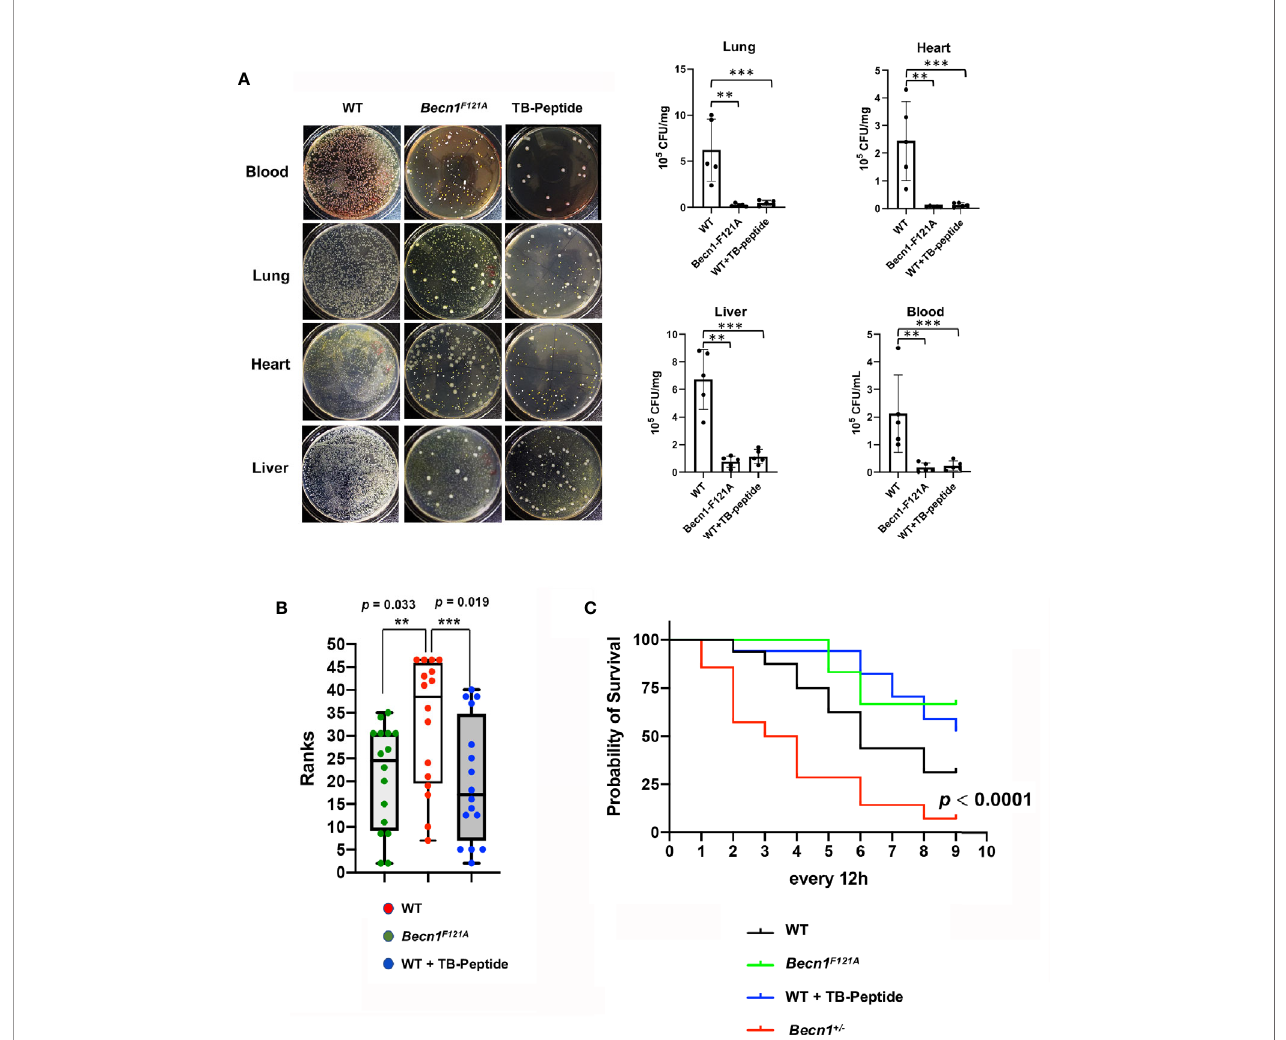
FIGURE 2 | Effects of Beclin-1 – dependent autophagy on local and systemic infection, clinical pain scores, and survival in pneumonia-induced sepsis. Mice of WT, Becn1 F121A/F121A , or Becn1 +/ − were given septic infection by K. pneumoniae (3X10 7 CFU/mouse, intubation). A parallel group of infected WT mice were treated with TB-peptide (16.5 mg/kg, i.p.) 1 h post-infection. (A) To evaluate infection, blood was collected, and organs harvested 48 h post infection. Blood serum and tissue lysates were plated on nutrient agar plates and incubated at 37°C for overnight. Bacterial colony formation was normalized with serum volume or lysate protein concentration. All values are means ± SEM. Signi fi cant differences are shown as ** for WT vs . Becn1 F121A/F121A , and *** for TB-peptide treated vs . untreated ( p < 0.05, n = 5, student t-test). (B) Post-infection physiological conditions were monitored and scored according to Table 1 at indicated time points. Kruskal – Willis H test for mean rank adjusted for multiple testing was applied, and differences were considered statistically signi fi cant when p ≤ 0.05 (** for WT vs . Becn1 F121A/F121A and *** for TB-peptide treated vs . untreated). (C) Survival curves were compared by a log-rank test, and differences were considered statistically signi fi cant when p ≤ 0.05. In B and C: n = 16 for WT, n = 12 for Becn1 F121A/F121A , n = 17 for WT plus TB-peptide, and n = 14 for Becn1 +/ −